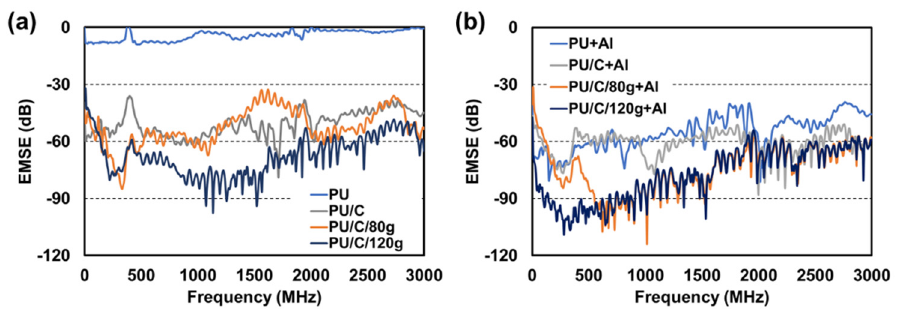
Figure 9. Electromagnetic wave shielding effectiveness of the PU foam composite planks, as related to ( a ) the content of carbon staple fibers and ( b ) the presence of aluminized film.